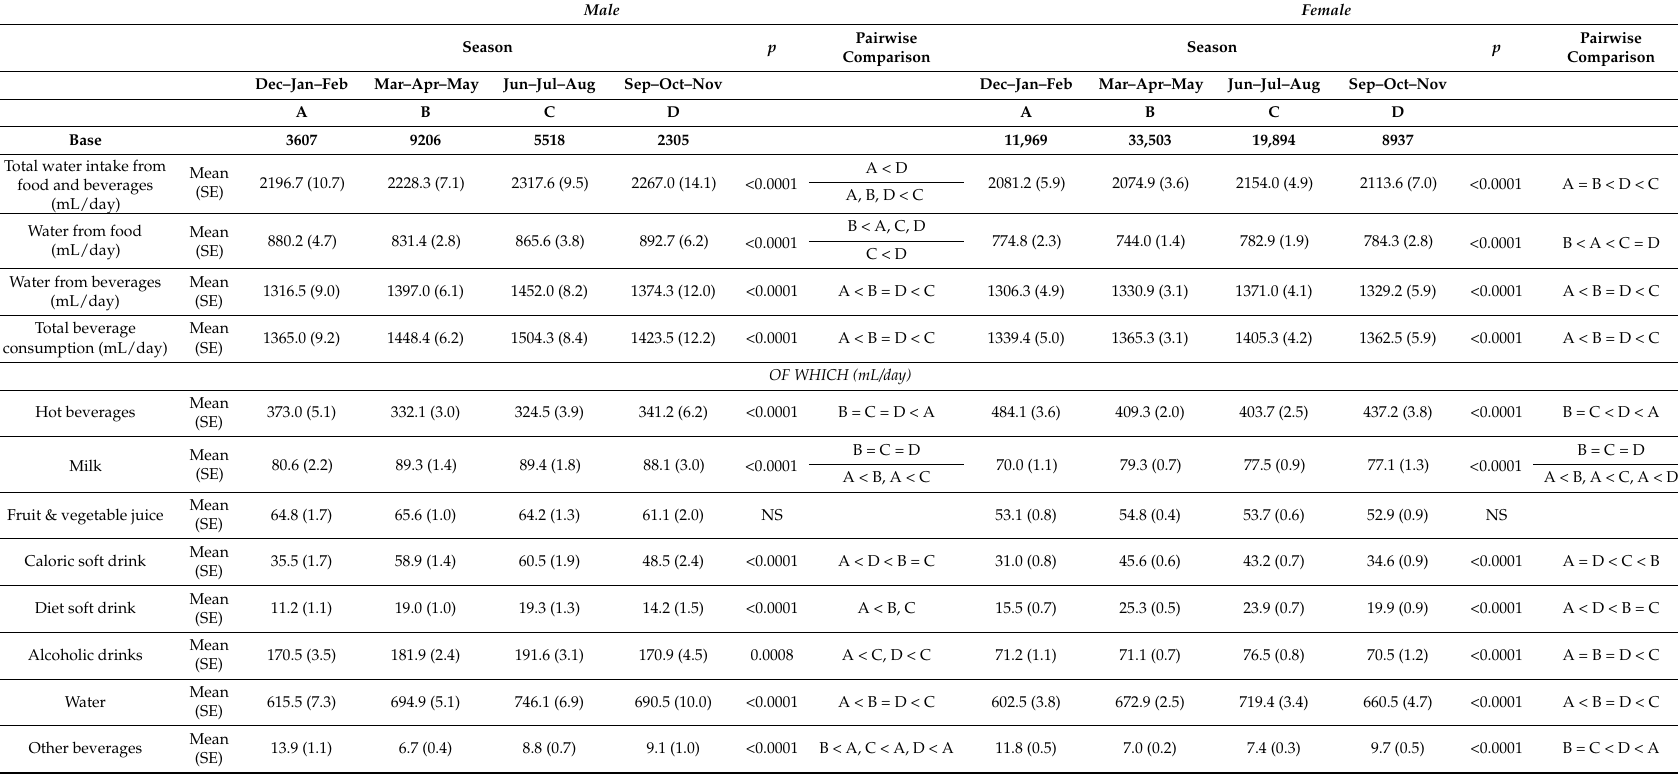
Table 5. Total water intake (g/day) and beverage consumption (mL/day), by season and by gender.